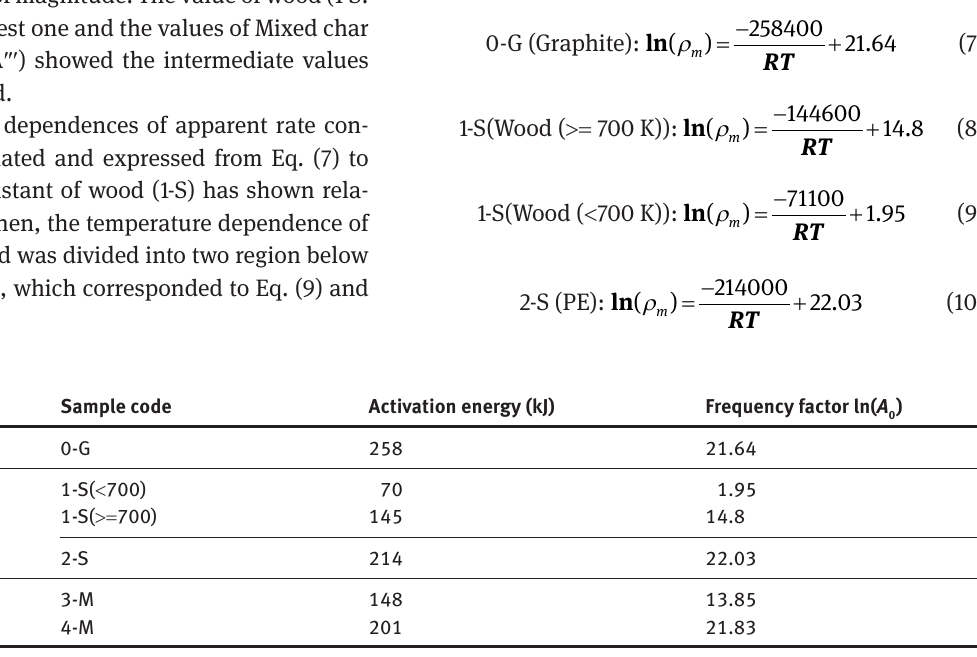
Table 2: Activation energies and frequency factors obtained.